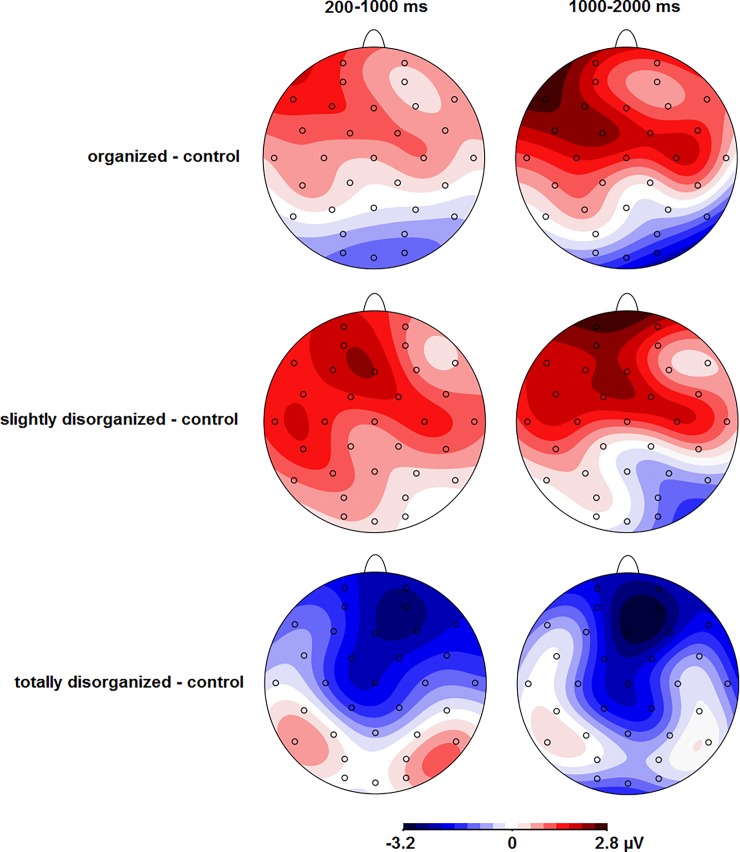
Scalp topographies of the difference waves in the two time windows.